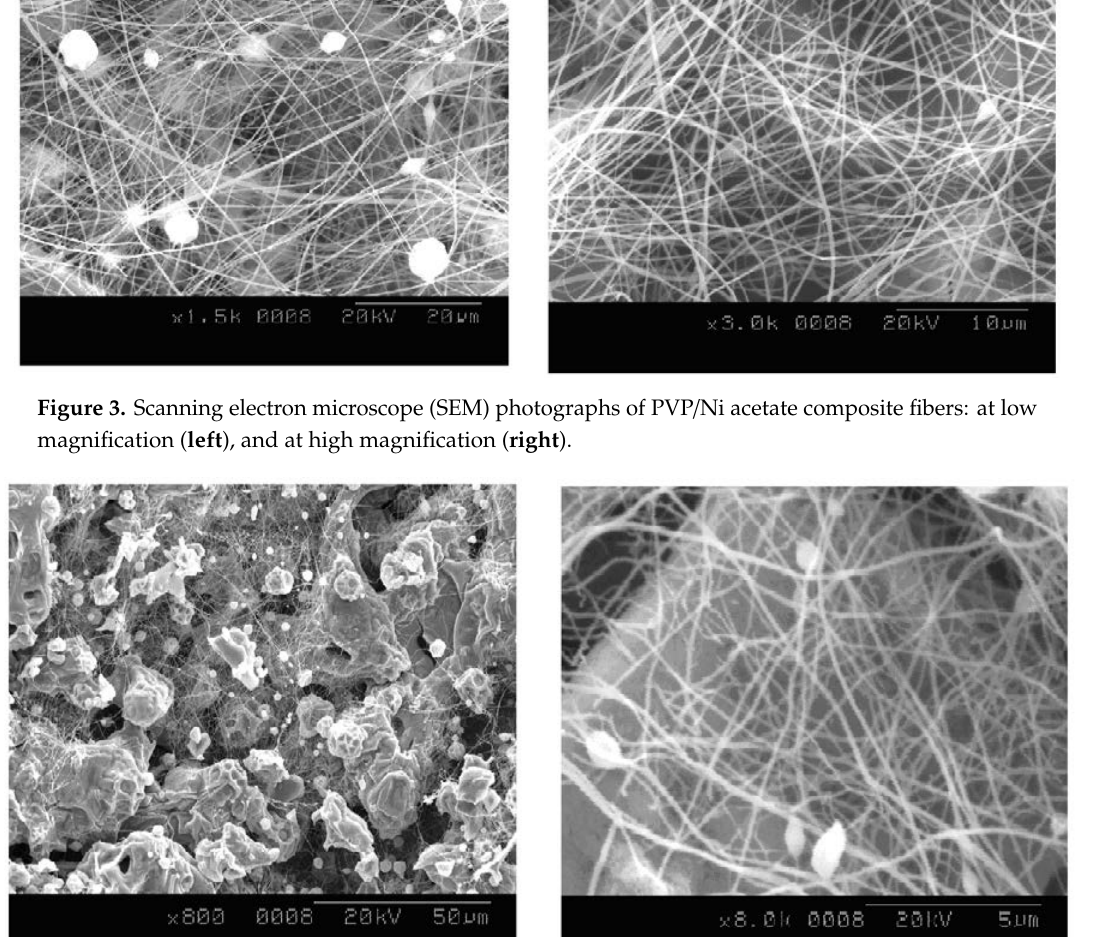
Figure 4. SEM photographs of NiO nanofibers: at low magnification (left), and at high magnification (right).